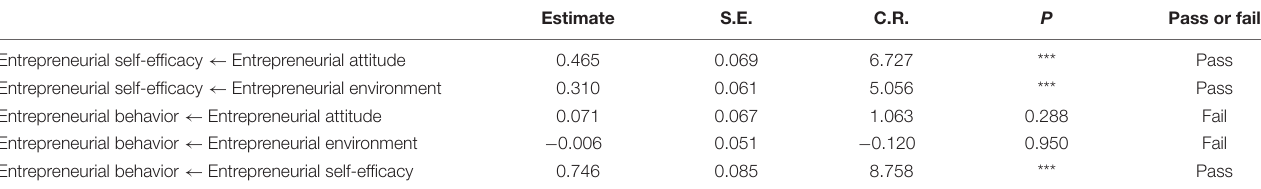
TABLE 4 | SEM related path inspection index.